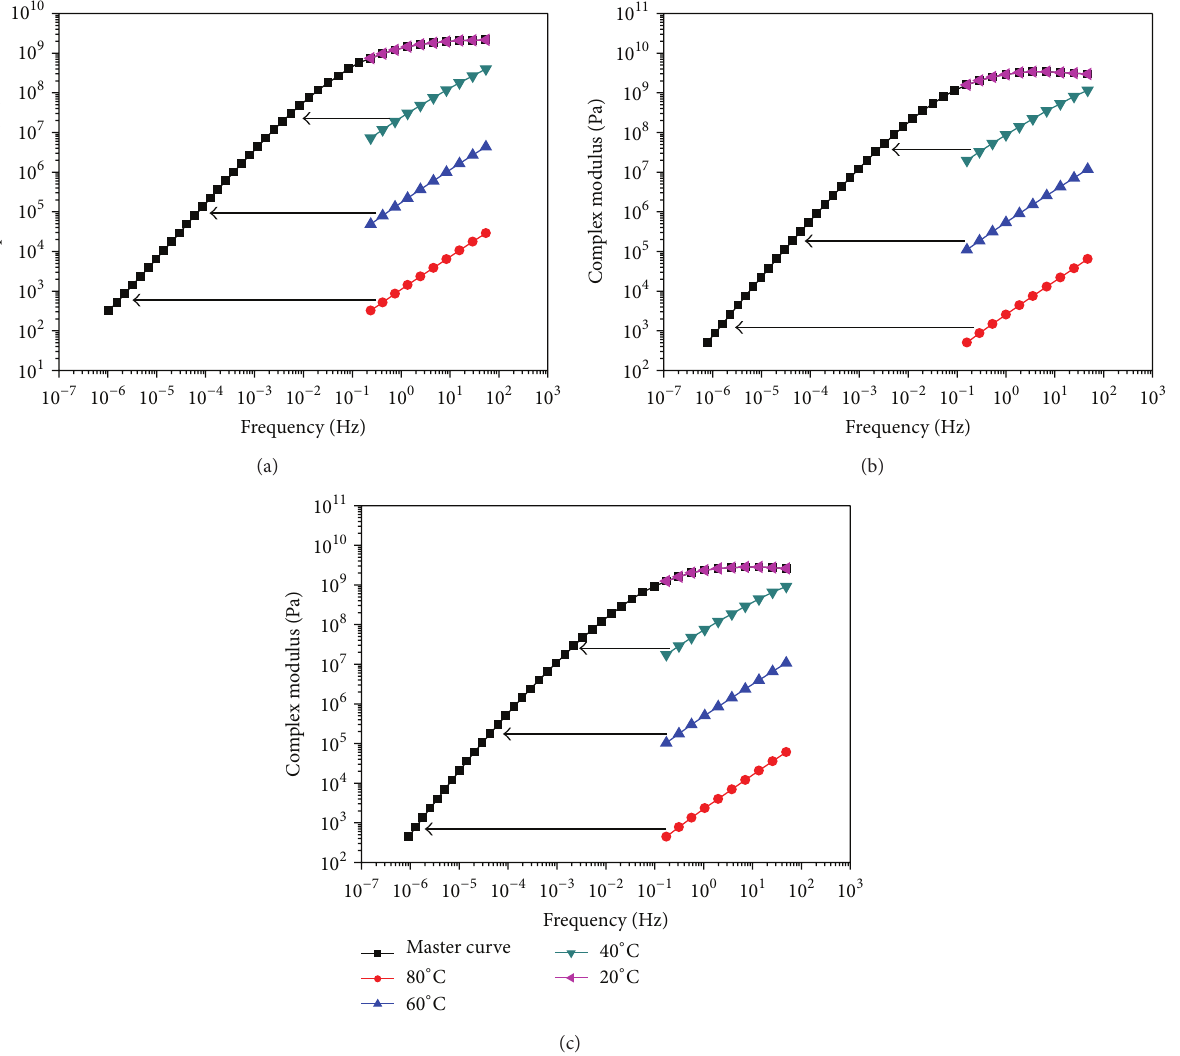
Figure 11: Master curve of (a) unaged SBS modified asphalt, (b) unaged Zn/Al-CO 32− -LDH modified asphalt, and (c) unaged Zn/Al-HNOB − - LDH modified